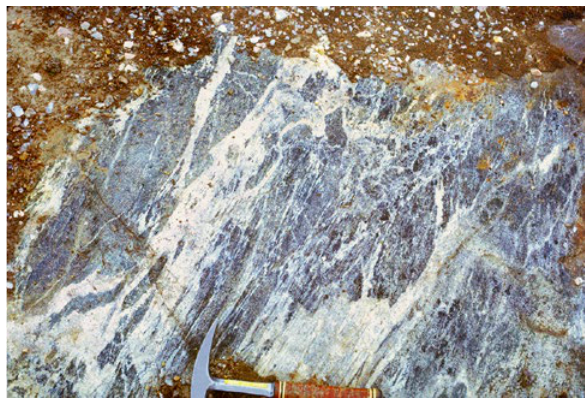
Figure 41. Vein quartz is “splashed in” and partly “soaked into” the host rock mass to give the impression of a very mobile penetrative fluid. However, some wall rock pieces appear isolated and suspen- ded in the vein material. This example is from the Macdonald Mine, Bancroft,